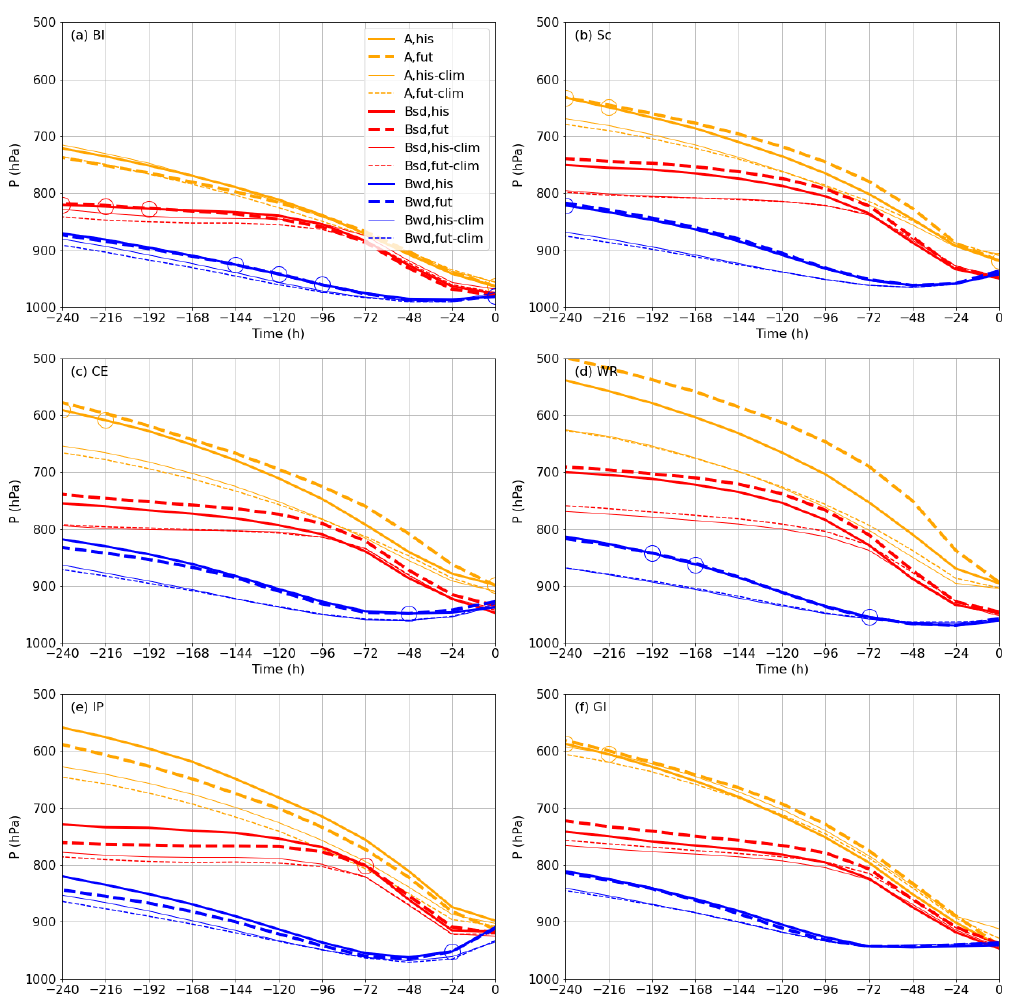
Figure 9. Median evolution of pressure (hPa) along the air parcel trajectories in clusters A, Bsd and Bwd in the six European regions. Bold solid (bold dashed) lines represent the air parcels associated with a heatwave event in the historic (future) time slice; accordingly the thin lines show the climatological JJA values. A significance test (Welch’s t test) was performed with a significance level ( p value) of 0.05. Large, open circles in the plots indicate insignificant ( p values > 0.05) differences between the medians of future and historic